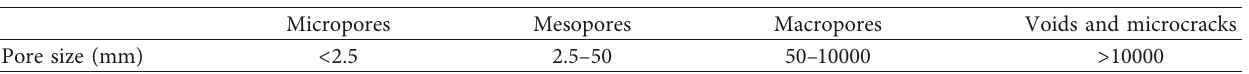
Table 3: The classifications of pores in the AAS pastes (according to the International Union of Pure and Applied Chemistry